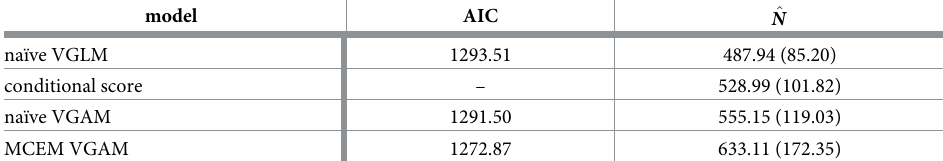
Table 2. AIC and population size estimates (standard errors in parenthesis) for each model fitted to prinia bird capture–recapture